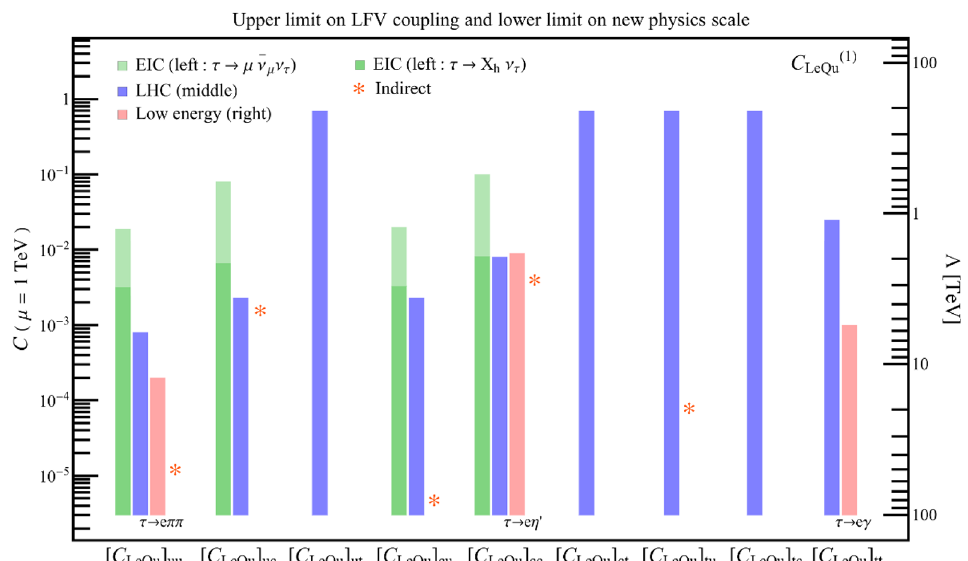
(leftmost axis) and lower limit on new physics scale Λ (rightmost Figure 21 . Upper limit on C (1) LeQu axis). For the EIC expected sensitivity, the light green bar corresponds to the result in table 7, while the dark green one represents the case in hadronic tau decay mode assuming (cid:15) n b = 0 in tables 3–5.